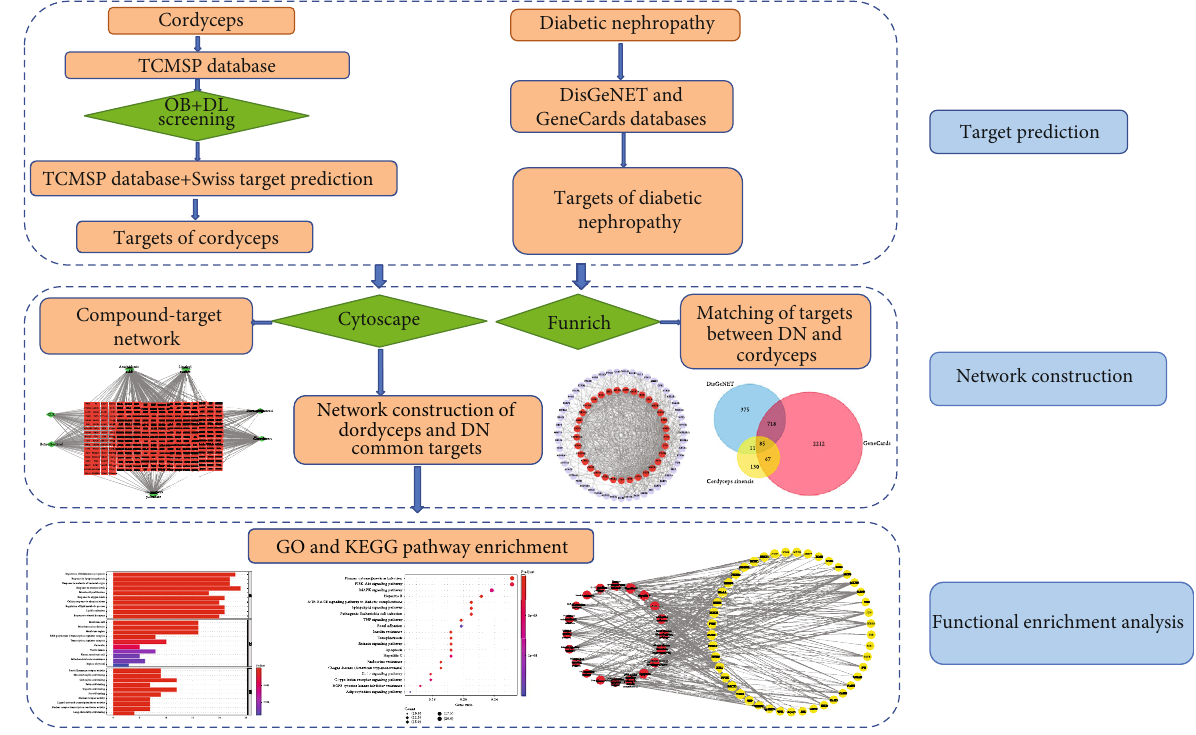
Figure 1: A fl ow chart based on an integration strategy of network pharmacology.